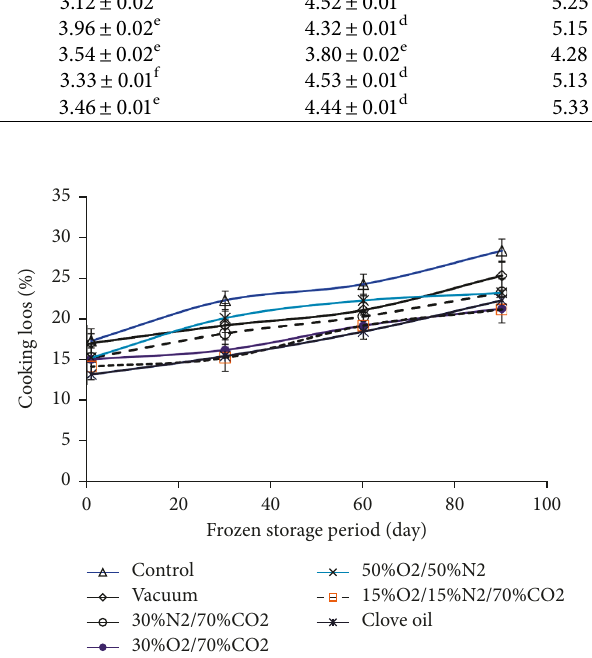
Figure 2: Cooking loss vs. FSP at different MAP treatments of